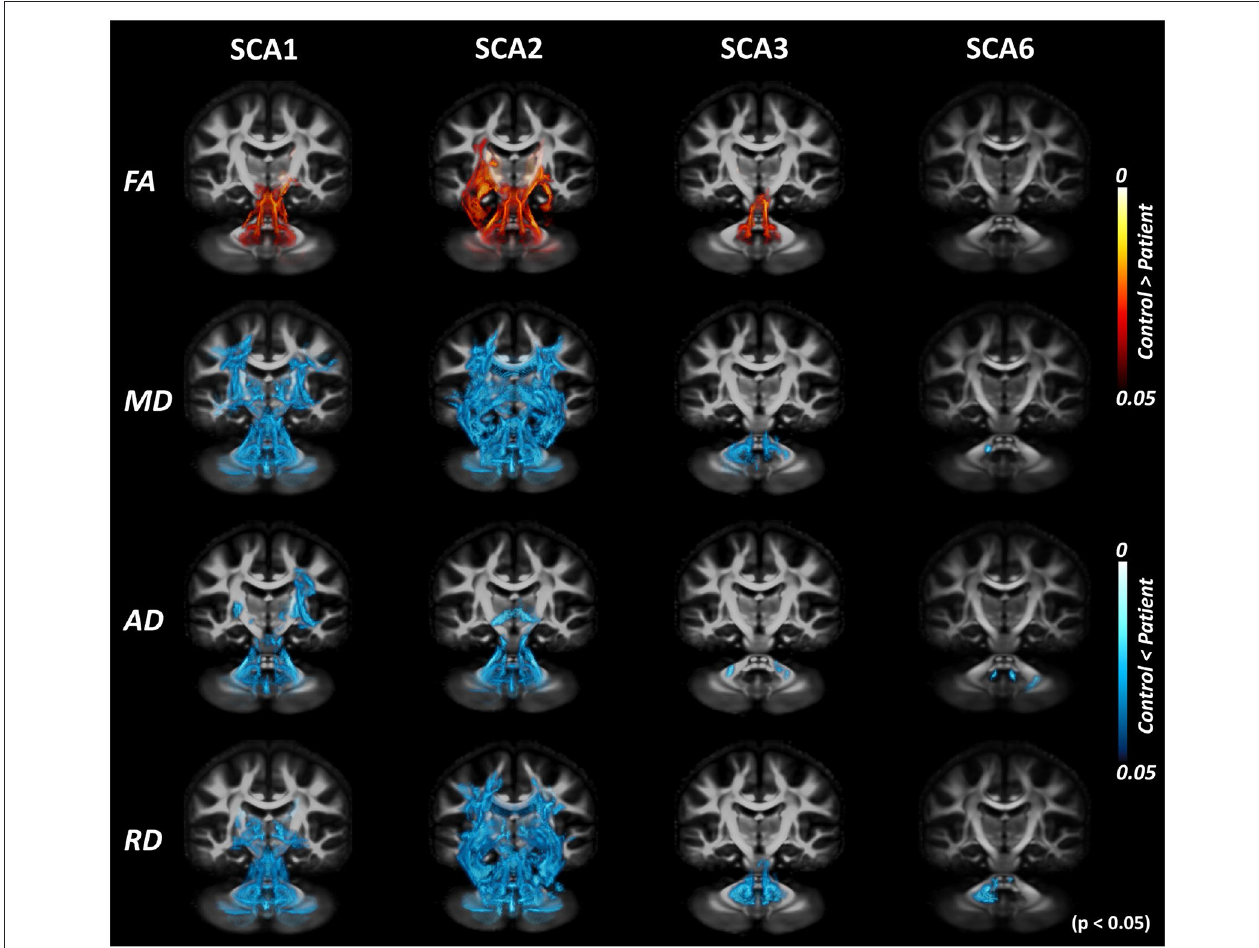
FIGURE 3 | Tract-based spatial statistics (TBSS) analysis with DTI-TK spatial normalization. Volume rendering of TBSS analysis results using ParaView identifies voxels with significant differences between patients with SCAs and healthy controls for SCA1, 2, 3, and 6. Red regions indicate the white matter locations with significantly lower values in patients, while blue regions indicate the white matter locations with significantly higher values in patients. This illustrates consistent trends of decreased fractional anisotropy (FA) and increased diffusivity (MD/AD/RD) throughout the brain across different